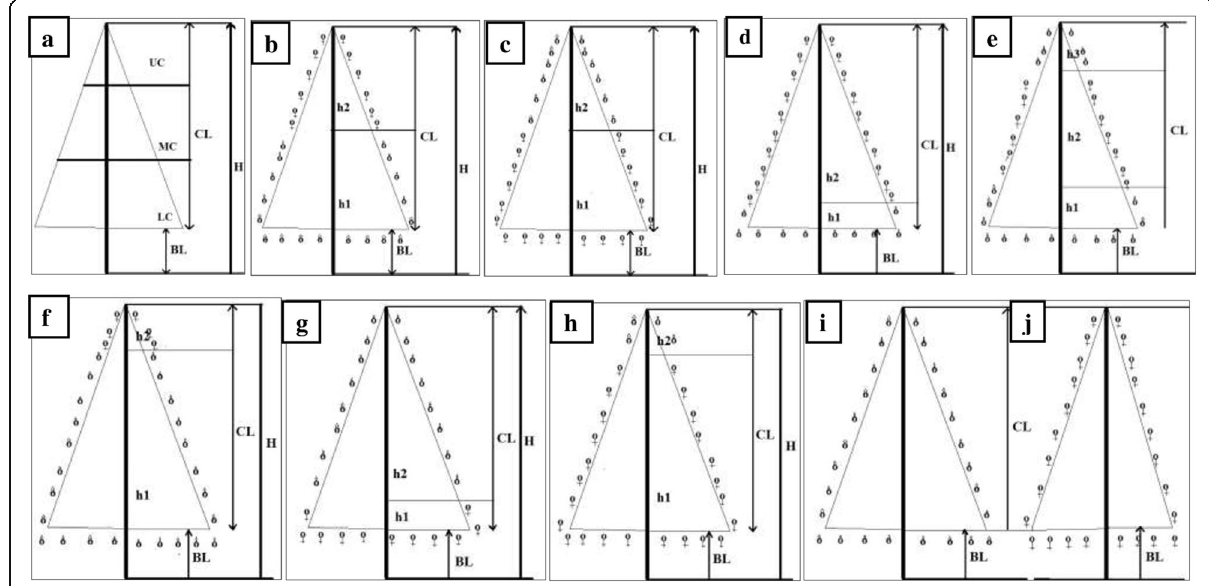
Fig. 1 Schematic representations of gender plasticity and sex expression in natural populations of Cedrus deodara. a Crown differentiation (LC: lover crown layer, MC: middle crown layer, UC: upper crown layer, CL: total crown length, BL: bole length, and H: total height), b mixed- monoecious (h1 ≈ h2, h1: length of LC, h2: length of UC) in which UC is female ( ♀ ) and LC is male ( ♂ ), c mixed-monoecious (h1 ≈ h2) in which UC is male and LC is female, d predominantly female (h2> h1, h2 ≥ 3/4 CL) in which UC is female and LC is male, e monoecious (h2 ≥ or ≤ (h1 +h3), h2: length of MC, h3 length of UC, h1 is the length of LC) in which LC is male, UC is male, and MC is female, f predominantly male (h1>h2, h1 ≥ 3/4 CL) in which LC is male and UC is female, g predominantly male (h1<h2, h2 ≥ 3/4 CL) in which UC is male and LC is female; h predominantly female (h1>h2, h1 ≥ 3/4 CL) in which LC is female and UC is male, i – j dioecious, i male tree, and j female